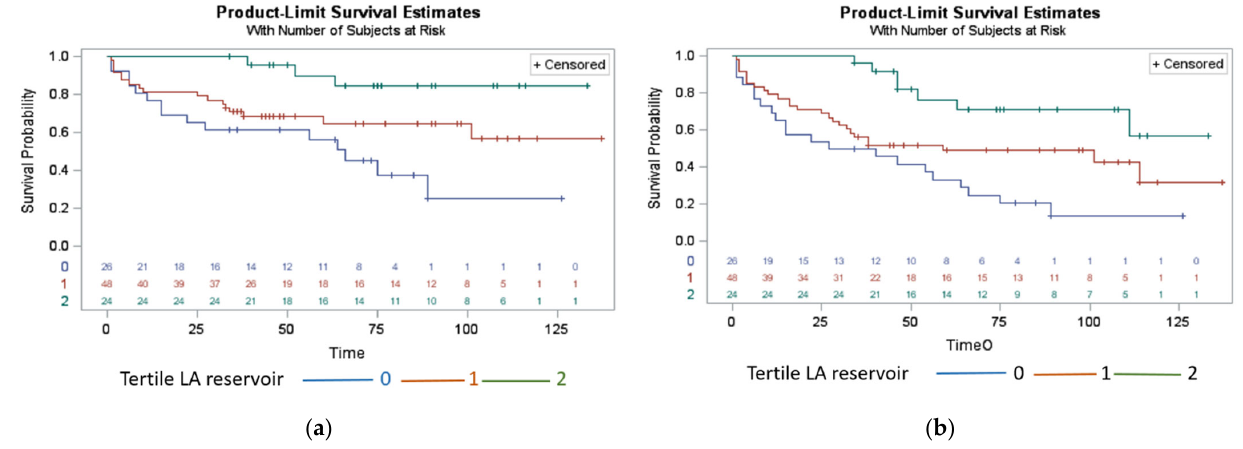
Figure 5. Kaplan–Meier plots of RCM patients’ survival and composite events by using mild, moderate, and severe LA functional impairment based on left atrial reservoir strain. ( a ) Patients in the lowest tertile with LA reservoir strain of <15% experienced death at earlier time points than patients with left atrial function >15% ( p = 0.008). ( b ) Patients in the lowest tertile with LA reservoir strain of <15% experienced composite events of death and cardiovascular hospitalizations at earlier time points than patients with left atrial function >15% ( p = 0.002). Left atrium = LA.